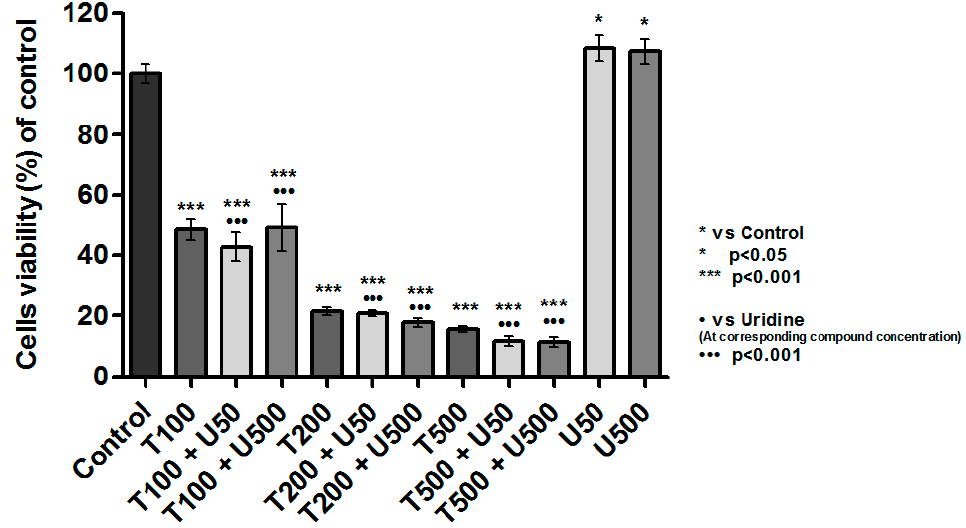
Figure 4. Relative multiple myeloma cell line RPMI 8226 viability treated with teriflunomide (T) (100–500 µM) and uridine (U) (50 and 500 µM) for 24 h determined by MTT assay. The results were calculated as % of control cultures viability which were averaged to define the 100%. Values were presented as mean ± SD derived from three independent experiments.